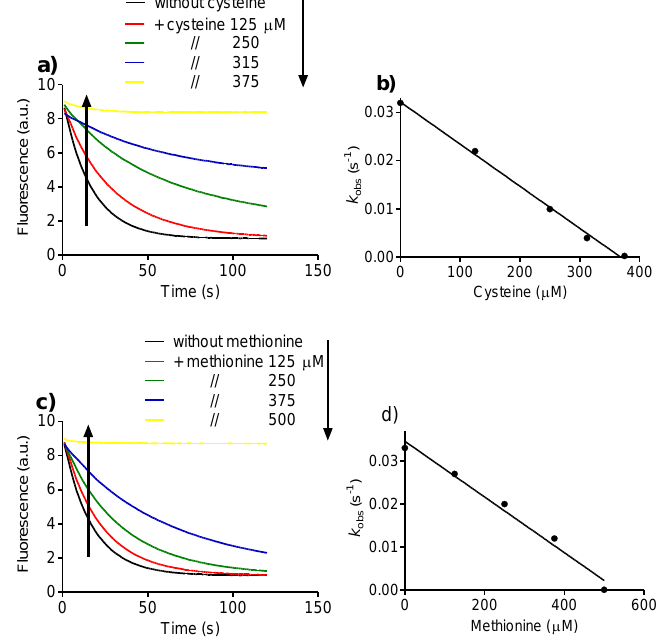
Figure 5. Cysteine versus methionine as targets for Tau-NHBr. ( a ) Reaction of dansylglycine with Tau-NHBr and the effect of cysteine; ( b ) Effect of cysteine on the pseudo-first-order reaction rate of dansylglycine with Tau-NHBr; ( c ) Reaction of dansylglycine with Tau-NHBr and the effect of methionine; ( d ) Effect of methionine on the pseudo-first-order reaction rate of dansylglycine with Tau-NHBr. The reaction mixture was composed of 25 µM dansylglycine, 500 µM Tau-NHBr and increasing concentrations of amino acids in 50 mM phosphate buffer, pH 7.0. The stopped-flow system was set as follows: excitation, 360 nm LED; and emission, 475 nm cut-off filter.